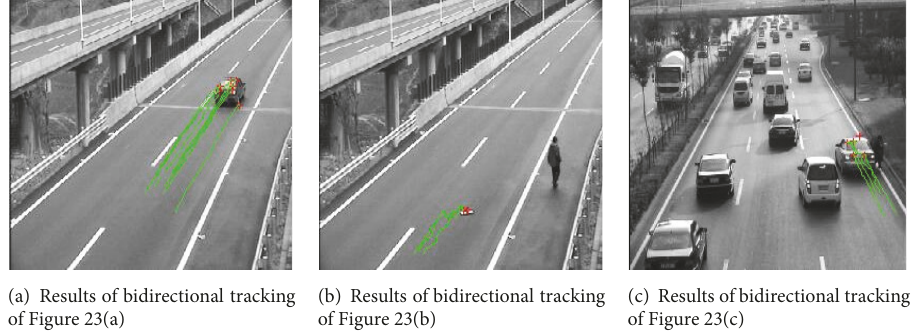
Figure 24: The result of bidirectional tracking of the corner points in Figure